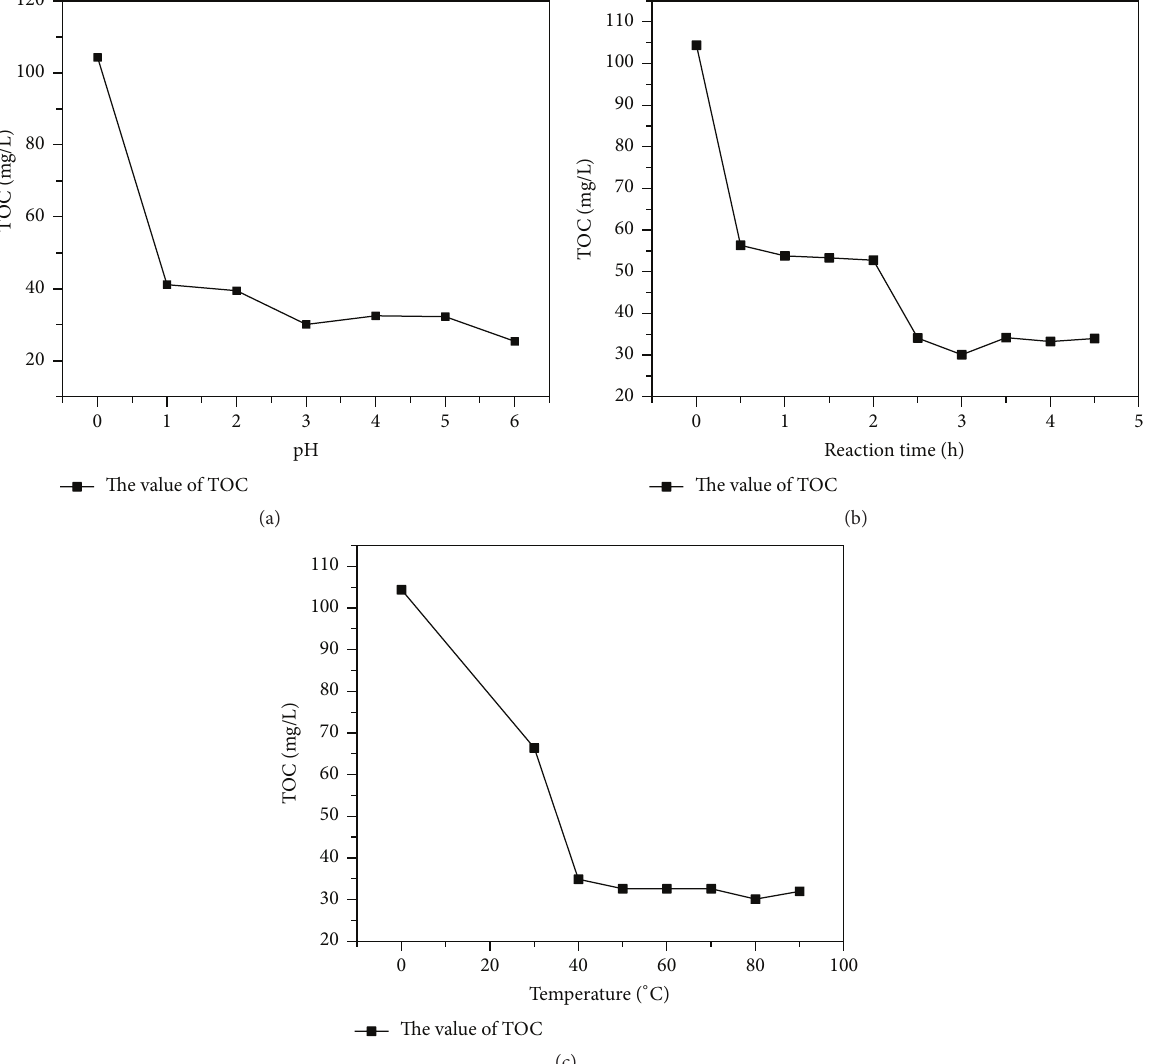
Figure 2: The change of TOC with the amount of reaction conditions (pH, time, and